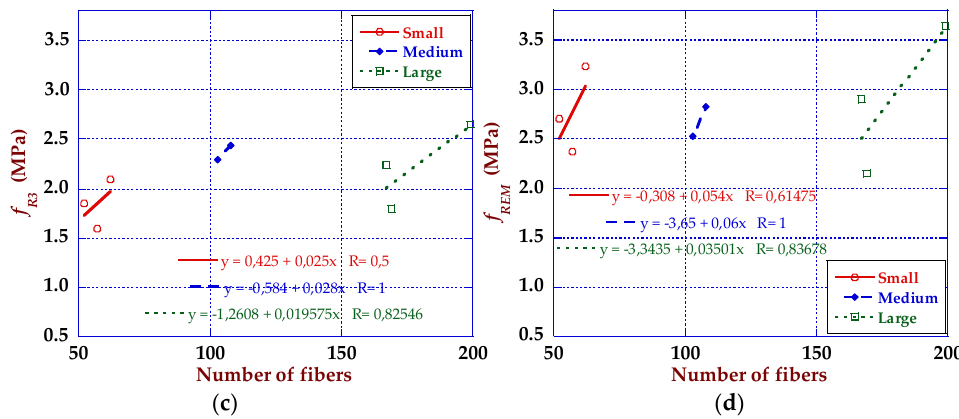
Figure 11. Tendency lines of the distinct residual strength values in relation to the number of fibres for the three specimen sizes: ( a ) for the minimum strength ( f MIN ), ( b ) for CMOD of 0.5 mm ( f R1 ), ( c ) for CMOD of 2.5 mm ( f R3 ) and ( d ) for the maximum residual post-cracking strength ( f REM ).